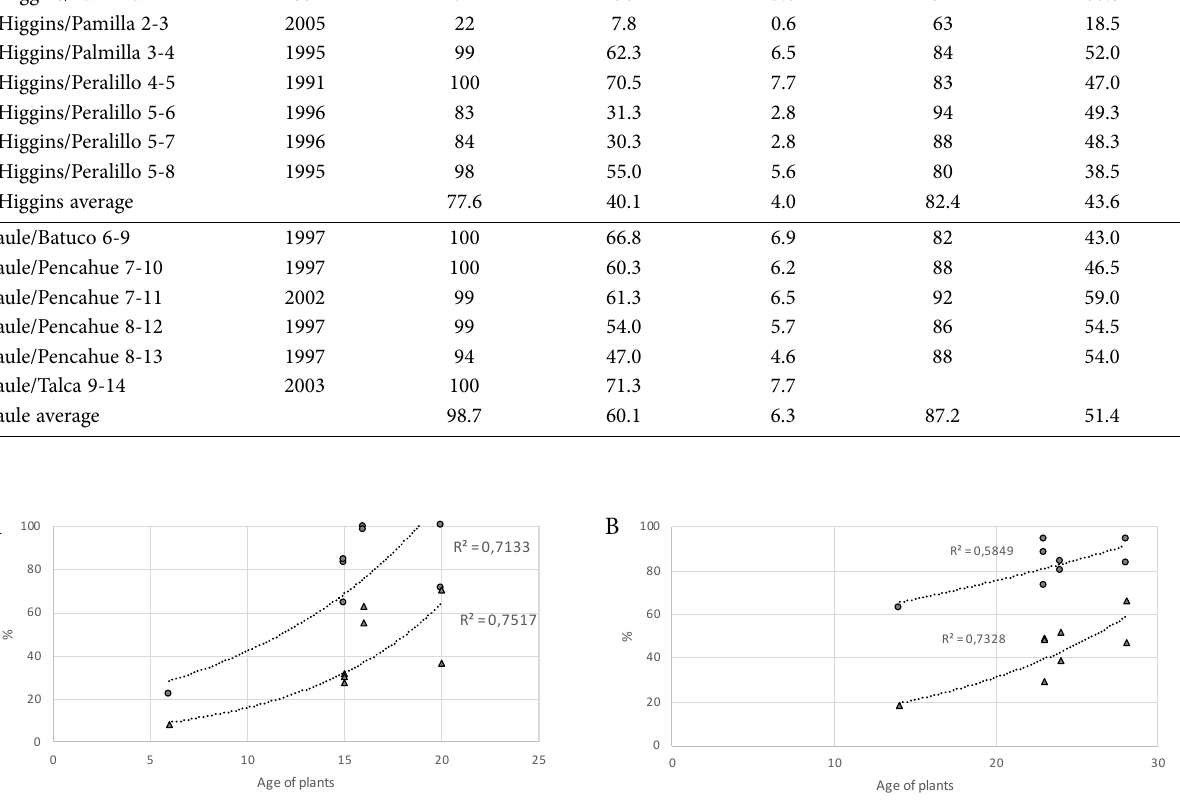
Region/Locality/Vineyard-